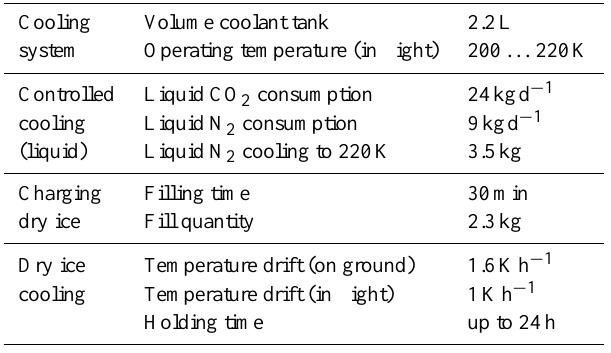
Table 2. Operational characteristics of the GLORIA cooling sys- tem.